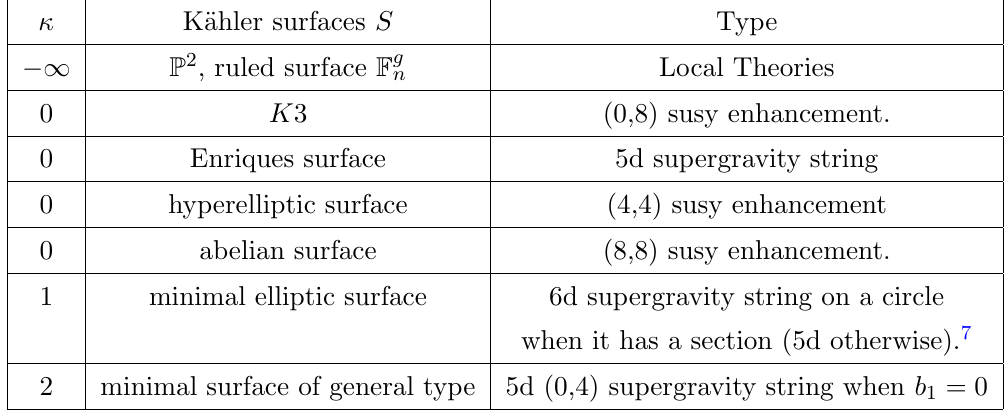
Table 1 . The (cid:12)rst column is the Kodaira dimension (cid:20) of the surface S. The second column presents the Enriques-Kodaira classi(cid:12)cation of minimal K(cid:127)ahler surfaces. The third column describes the surfaces of the second column that could be 5d supergravity strings as de(cid:12)ned in section 2.3. class is [ P ] 2 H 2 ( X; Z ), which we will also write as P for simplicity. In particular, P can be expressed with respect to a basis ! of H 2 ( X; Z ) and charges q I (cid:21) 0 as P = P q I ! , I I meaning that the divisor is